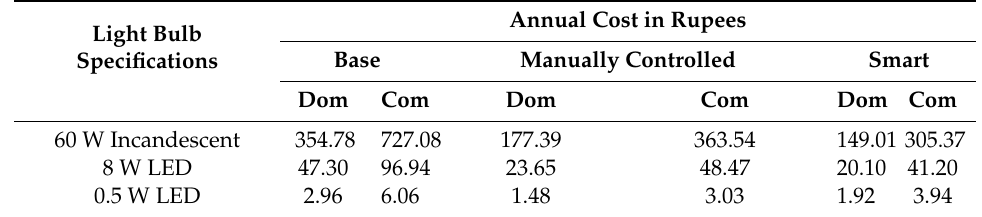
Figure 5. Graph for energy consumption of a 60 W incandescent light bulb in three scenarios.